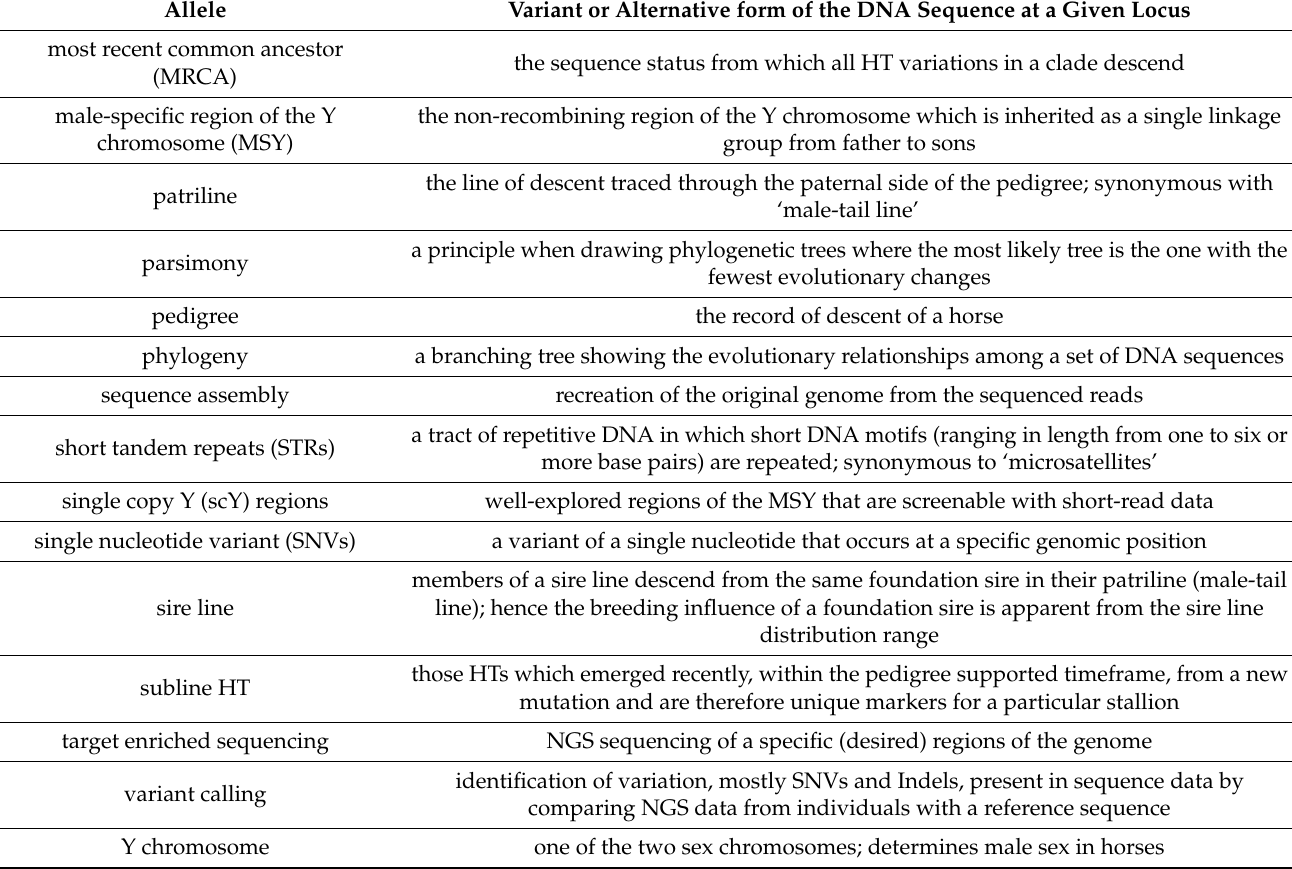
Figure A2. NGS data analysis pipeline. Two NGS data sets were merged to produce the final struc- ture: mappings of 118 WGS males to LipY764 from a previous study and newly generated TES data